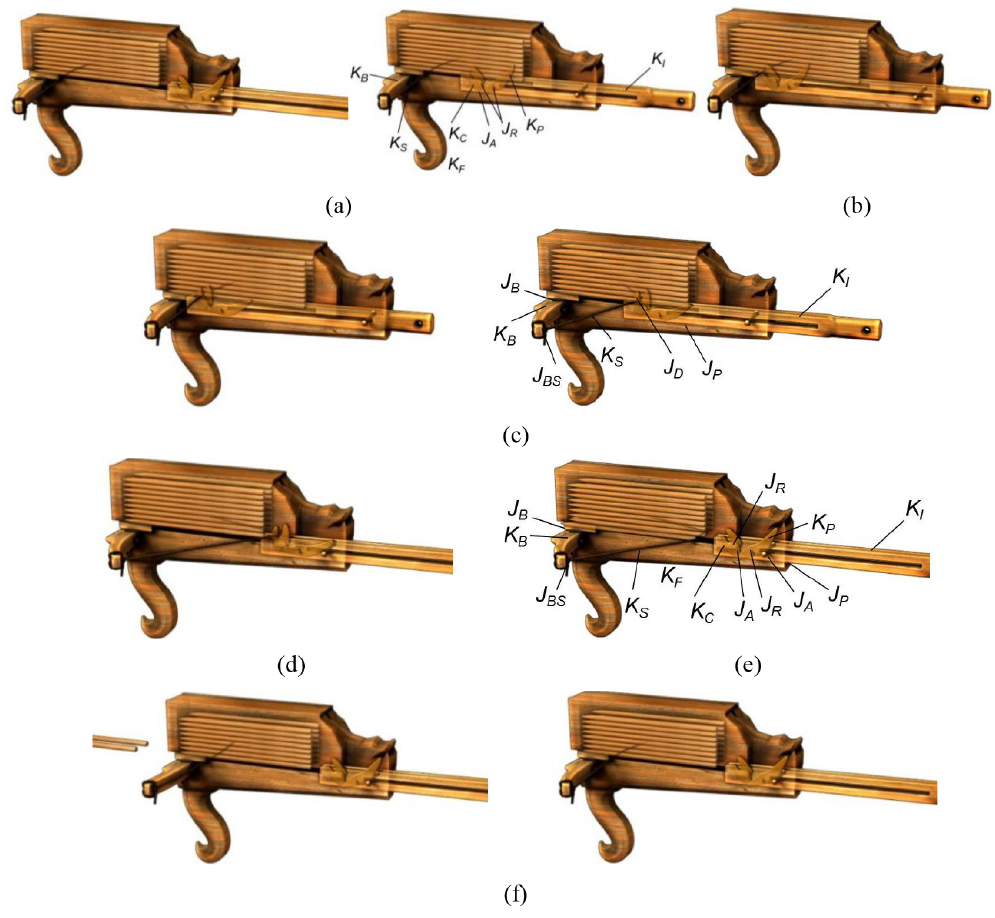
Figure 6. Shooting process of a Chu State repeating crossbow.